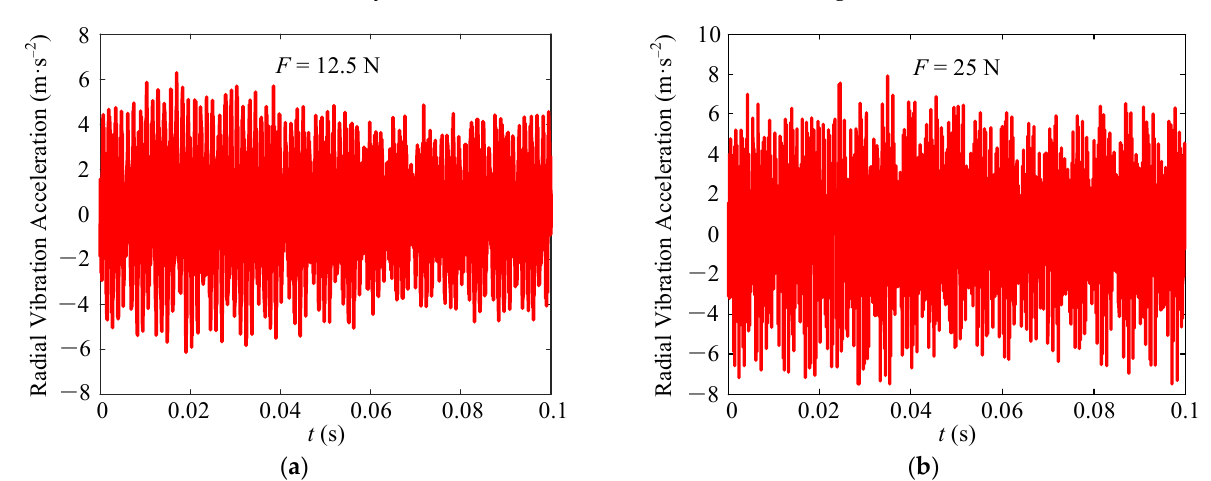
Figure 6. Radial vibration acceleration response obtained by theoretical simulation: ( a ) radial vibration acceleration under 12.5 N load and ( b ) radial vibration acceleration under 25 N load.